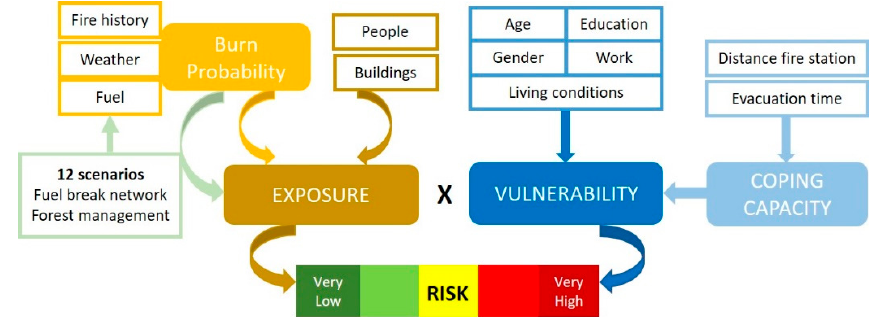
Figure 3. Schematic representation of the risk analysis procedure implemented. The variables used to estimate exposure and vulnerability are presented in Table 1. The 12 management scenarios are described in Section 2.4.